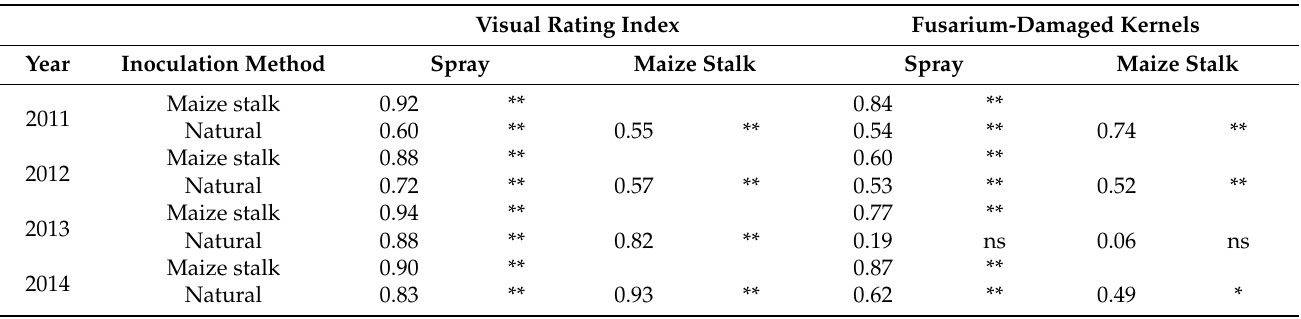
Table 3. Spearman’s rank correlation coefficients between inoculation methods for visual rating index and Fusarium-damaged kernels in 2011, 2012, 2013, and 2014.